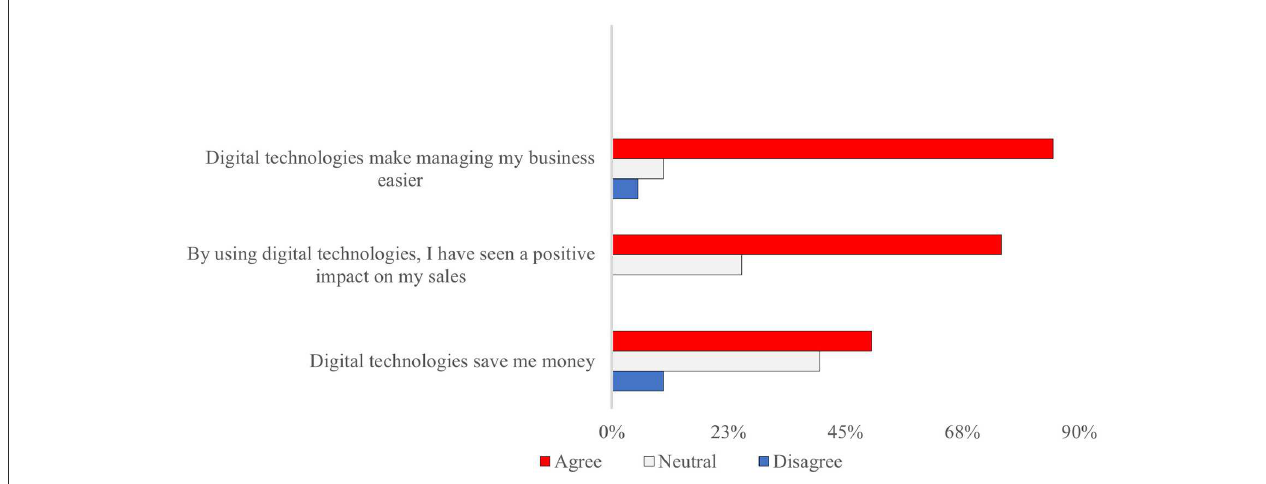
FIGURE3 Perceived benefits of digital technology use.